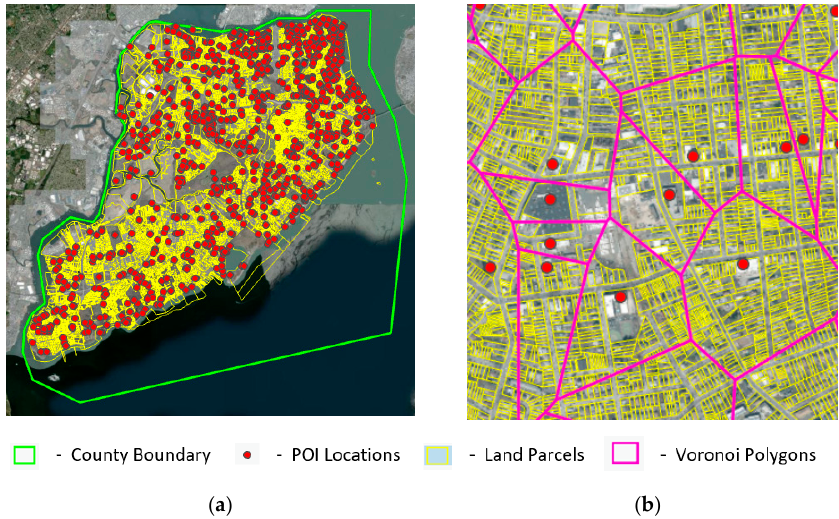
Figure 2. ( a ) Land parcels and POI locations within the Richmond County (Staten Island) overlaid on imagery basemap [32] ( b ) Voronoi polygons and their associated POIs within a section of Richmond County.